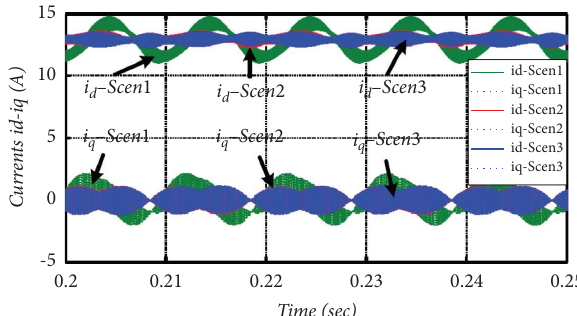
Figure 14: dq axis input current for both proposed and conventional controller in various scenarios.